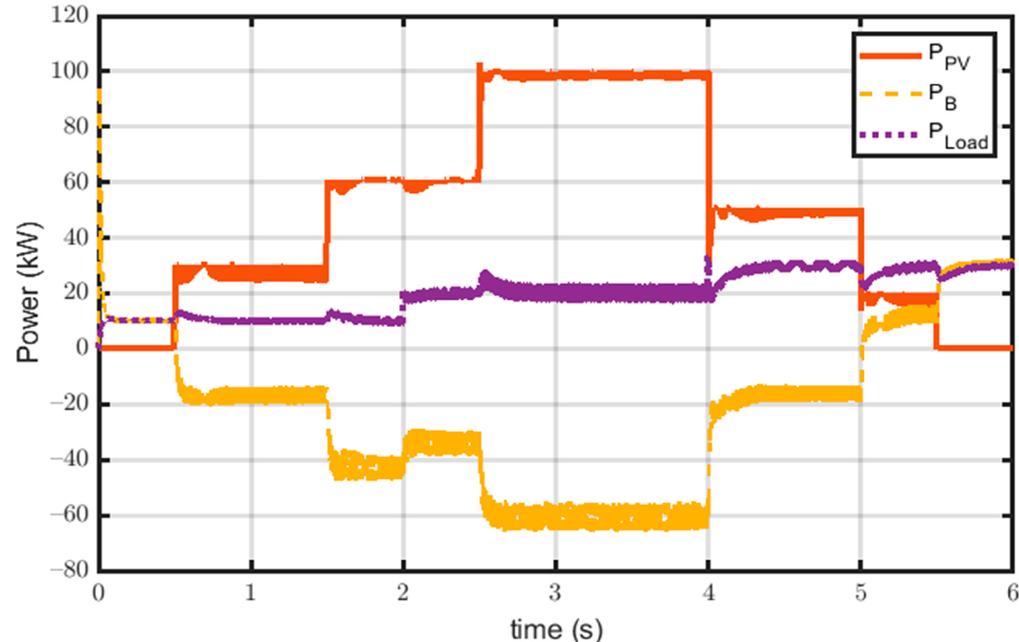
Figure 12. Power flow in islanded PV microgrid with different load demands.